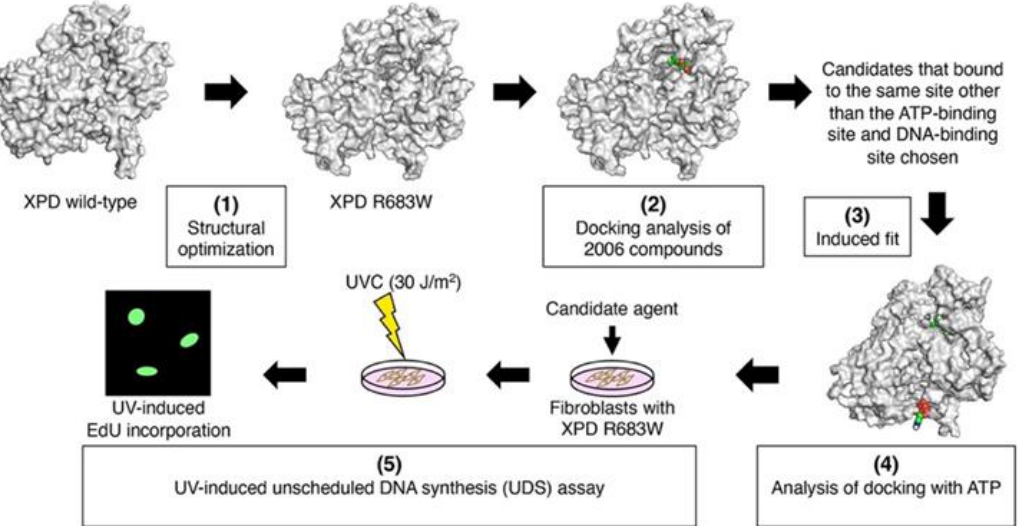
Figure 1. Schematic drawing of in silico drug repurposing (DR) and in vitro evaluations. The in silico DR procedure, by which we discovered therapeutic candidates, consisted of five steps: (1) analyzing the 3D structure of xeroderma pigmentosum complementation group D (XPD) R683W, (2) docking of XPD R683W with 2006 bioactive compounds, (3) performing induced fit with 5 complexes selected from 152 complexes, (4) evaluation of ATP docking with induced-fit XPD R683W, and (5) performing an in vitro DNA repair assay that used UV irradiation.